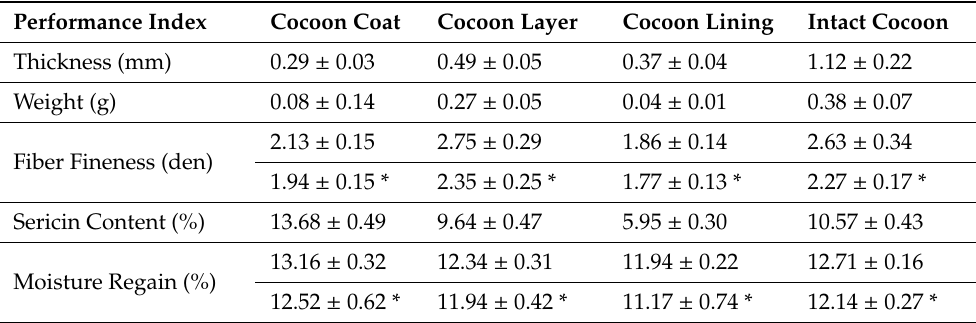
Table 2. Fiber properties of the three layers in E